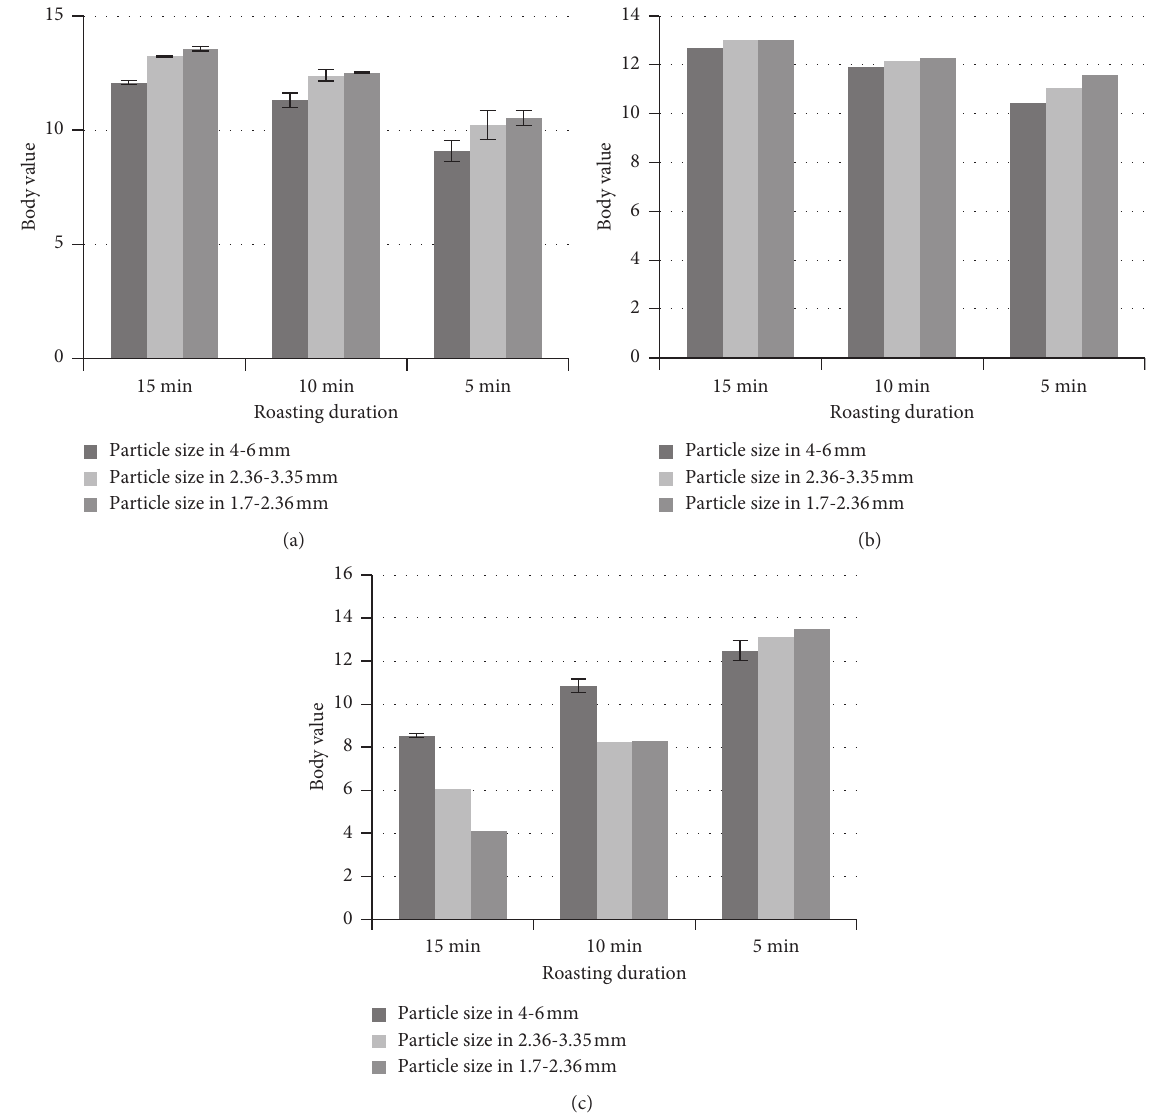
Figure 6: Effect of coffee bean particle size, roasting temperature, and roasting time on the body value of the coffee beverage. (a) Roasting temperature at 200 ° C. (b) Roasting temperature at 230 ° C. (c) Roasting temperature at 260 °